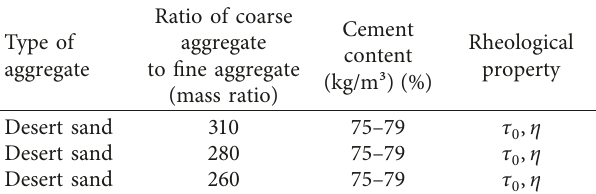
Table 4: Rheological test of the liquid